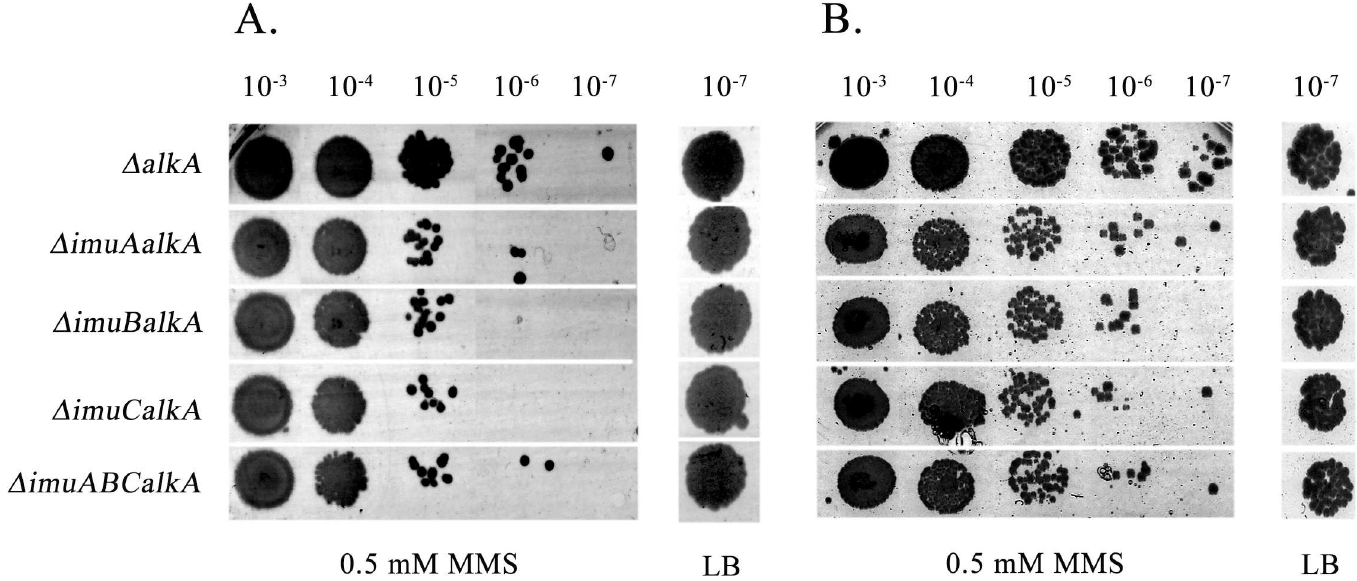
Fig 6. Study of the requirement of imuA and imuB for the alkyl damage tolerance. S ensitivityof P . aeruginosa (A) and P . putida (B) Δ alkA strains and their imuA- , imuB- , imuC- and imuABC -deficient derivatives to MMS was compared. Sensitivity was estimated by spotting 10-folddilutionsof overnight cultures of P . aeruginosa or P . putida onto LB plates supplemented with 0.5 mM MMS and incubatedat 37˚C or 30˚C for 24 h, respectively.